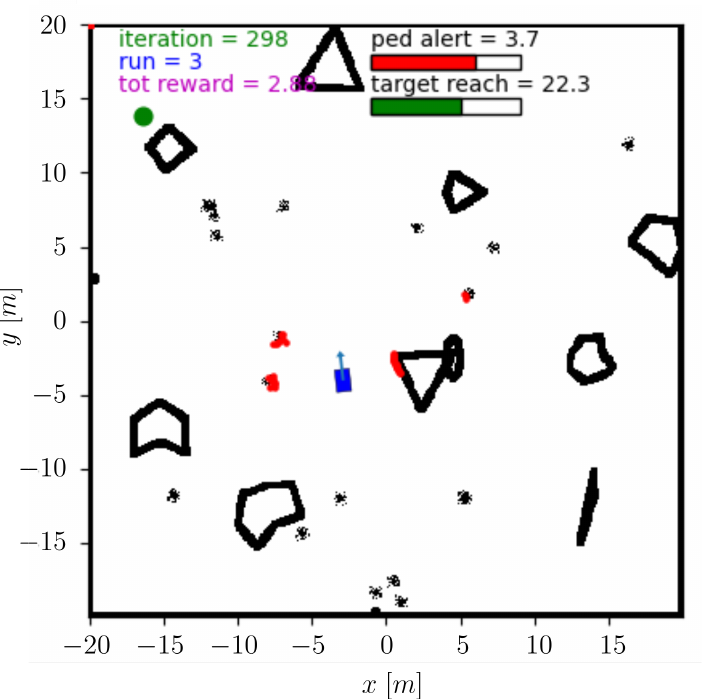
Figure 5. Learning environment: the blue rectangle represents the robot and the arrow its current heading; the red dots show the LiDAR scanner readings; the green circle represent the target location that the robot must reach; finally, in black the obstacles are represented. Obstacles can be either static or dynamic (black dots represent